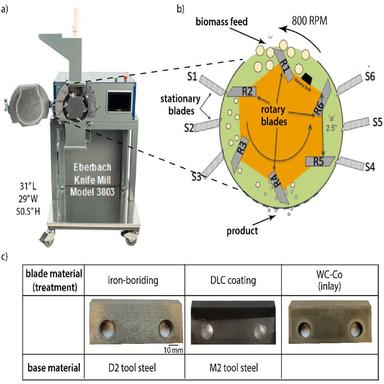
Experimental setup. a) Knife mill used in the experiments. b) Schematic of a milling procedure depicting an interaction between stationary, rotary blades and feedstock. c) Images of the blades.